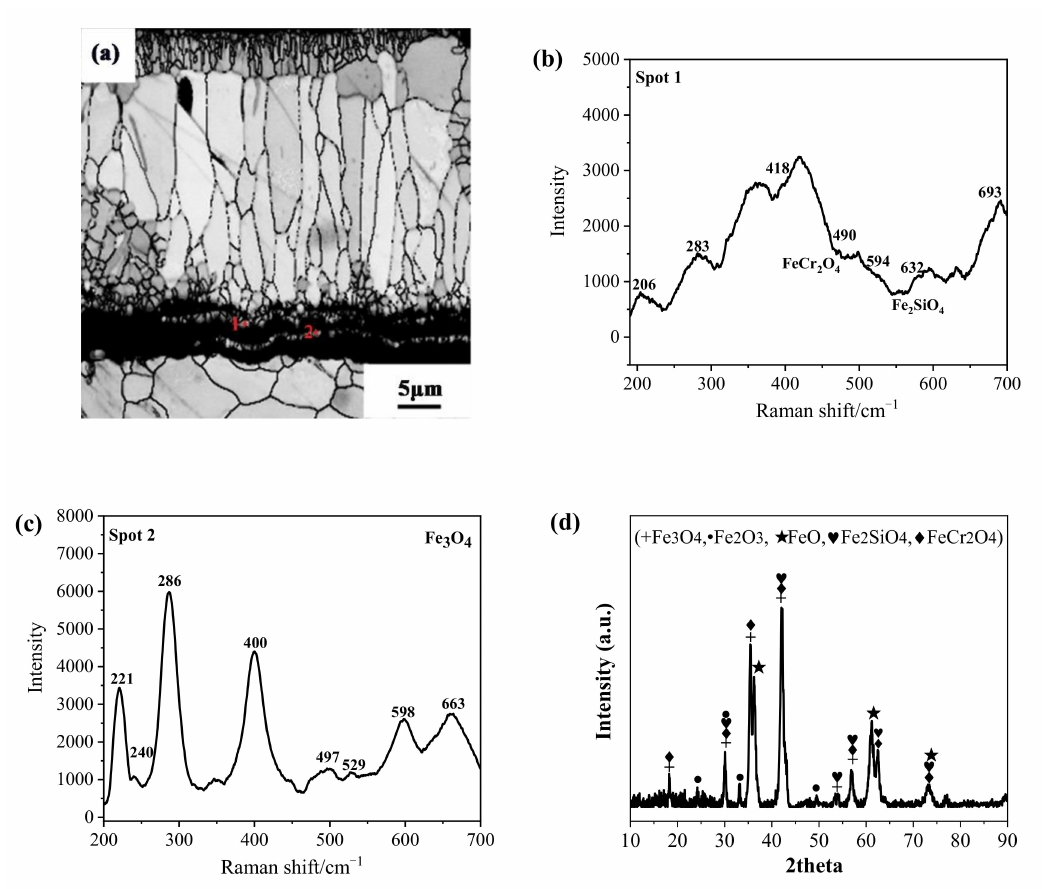
Figure 5. Raman spectroscopy spot analysis of the oxide scale with the thickness reduction of 10% and cooling rate of 11 ◦ C/s, ( a ) oxide layer morphology and position, ( b , c ) Raman spectrum at the interface of the oxide scale and the substrate. ( d ) XRD spectra of the oxide